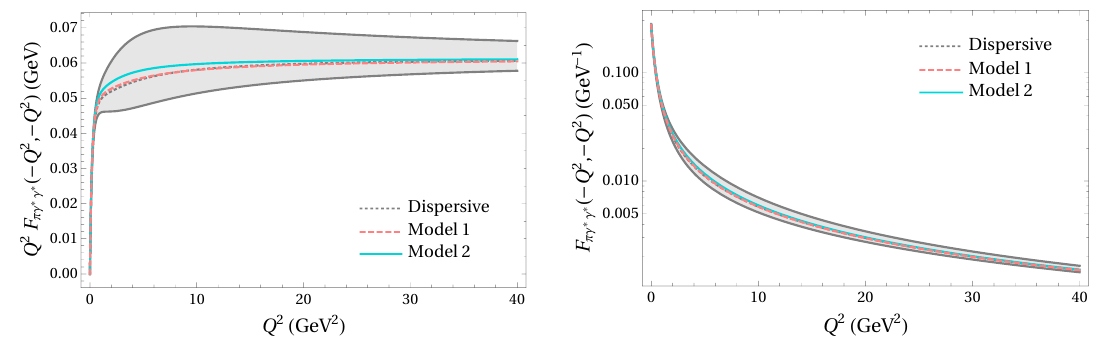
Figure 24. Doubly-virtual (cid:25) 0 TFF in the symmetric region Q 2 where Q 2 = Q 2 and Q 2 = 2 Q 2 (right). Legend is the same as in (cid:12)gure 23. 1 2